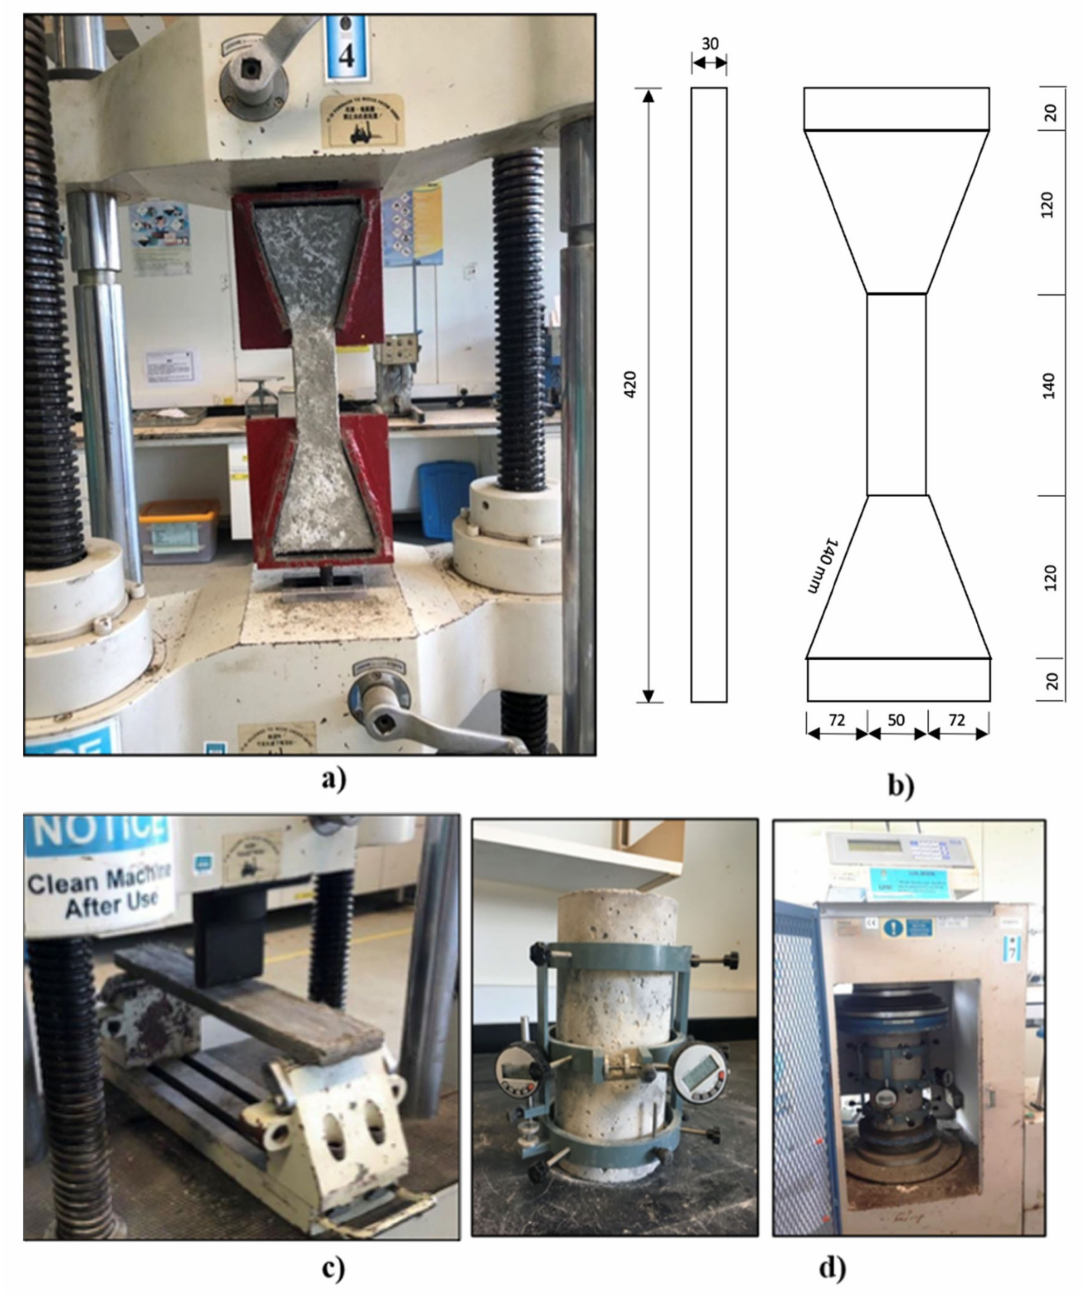
Figure 2. Experimental testing setup for the ( a ) direct tensile test (dog-boned); ( b ) dog-boned-shaped dimensions (unit = mm); ( c ) three-point bending test; and ( d ) elastic modulus and Poisson’s